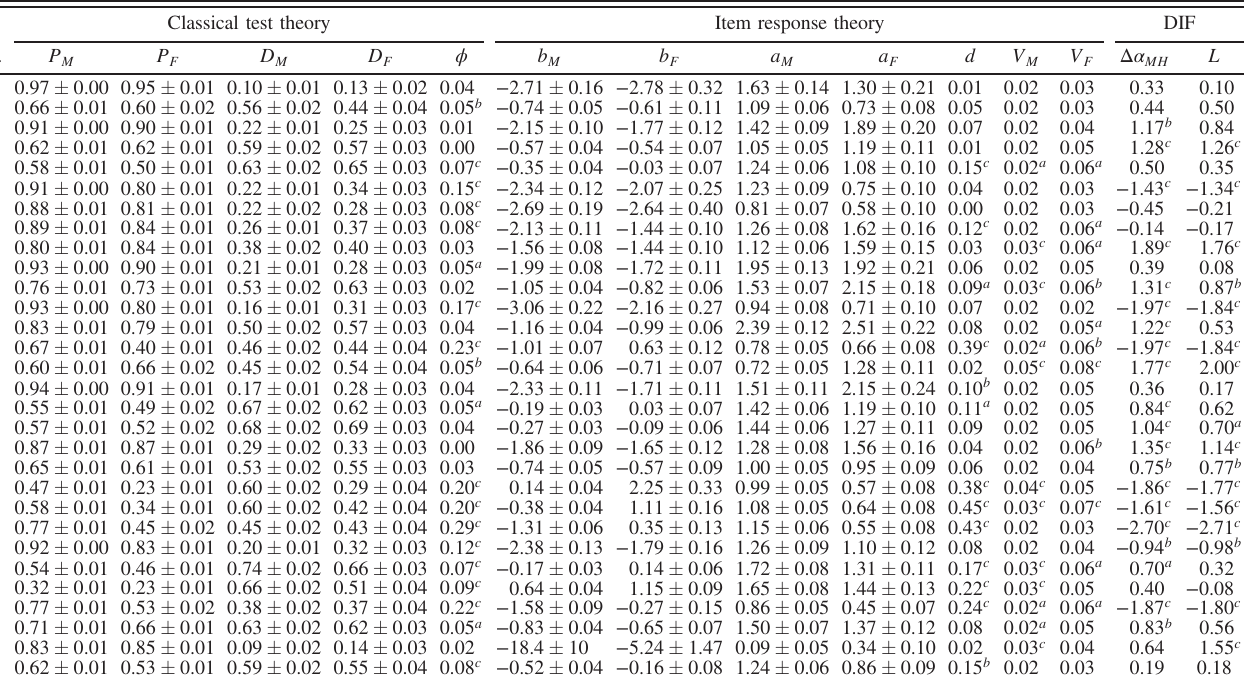
TABLE III. Classical test theory and Item response theory results for Sample 1 for each FCI item. Male results are marked ( M ) and female results ( F ). Significance levels have been Bonferroni corrected for the number of statistics tests: “ a ” denotes p < 0 . 0017 , “ b ” p < 0 . 000 33 , and “ c ” p < 0 . 000 033